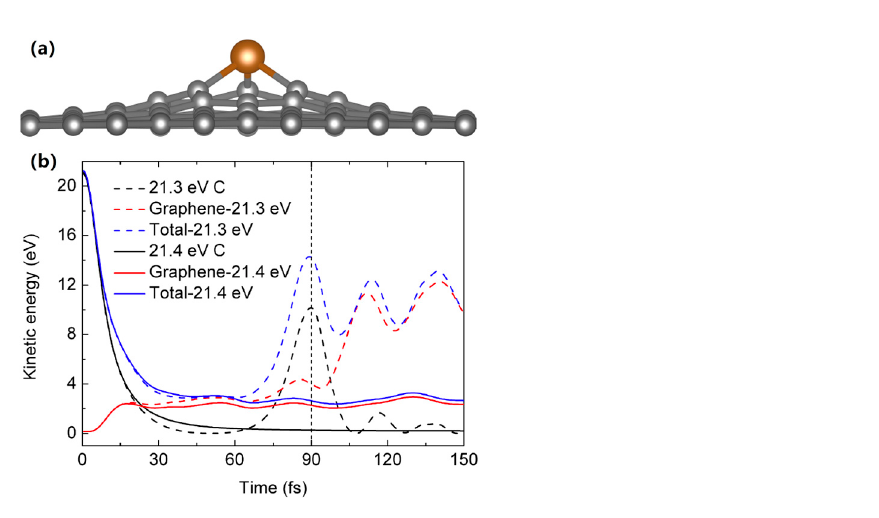
Figure 2. ( a ) Schematic diagram of the final atomic configuration of Ga, Ge or As atom-doped graphene, the bonding lengths of Ga-C, Ge-C and As-C are 1.88 Å, 1.89 Å and 1.91 Å, respectively. ( b ) The impacted C atom with 21.4 eV kinetic energy can escape from the graphene layer, while the impacted C atom with 21.3 eV kinetic energy could return into a graphene lattice; therefore, the displacement threshold energy of pristine graphene is 21.4 eV.